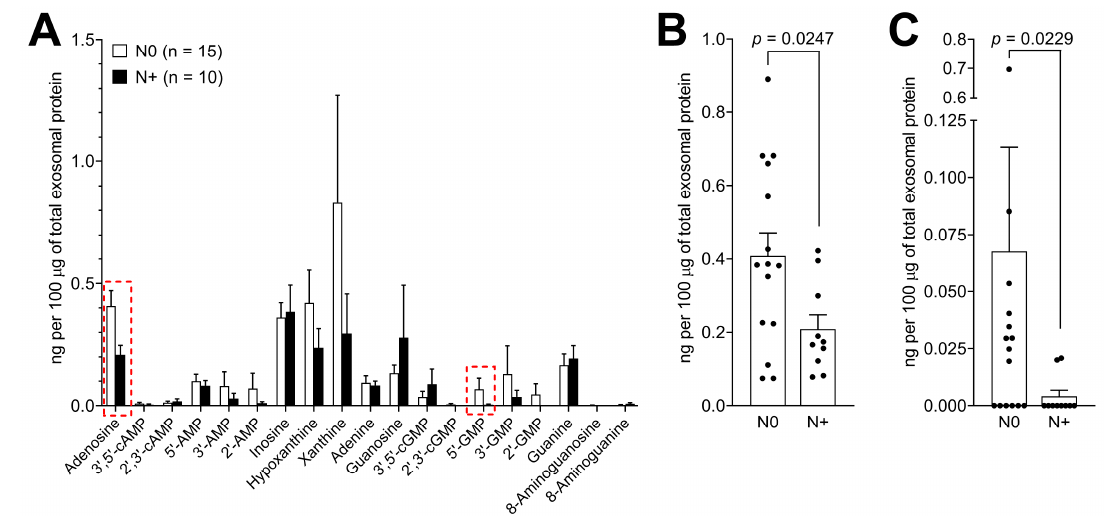
Figure 6. Purine metabolite levels in plasma-derived exosomes of HNSCC patients according to lymph node status. ( A ) Values presented in Figure 3B were divided based on the lymph node status (N status) and levels of purine metabolites were compared in exosomes isolated from the plasma of patients with lymph node metastasis (N+) to patients without metastasis (N0). ( B ) Individual values of adenosine levels in plasma-derived exosomes from HNSCC patients with indicated lymph node status. Values correspond with the data marked with the red frame presented in (A). ( C ) Individual values of 5 ′ -GMP levels in plasma-derived exosomes from HNSCC patients with indicated lymph node status. Values correspond with the data marked with the red frame presented in (A). All values represent means ± SEM.